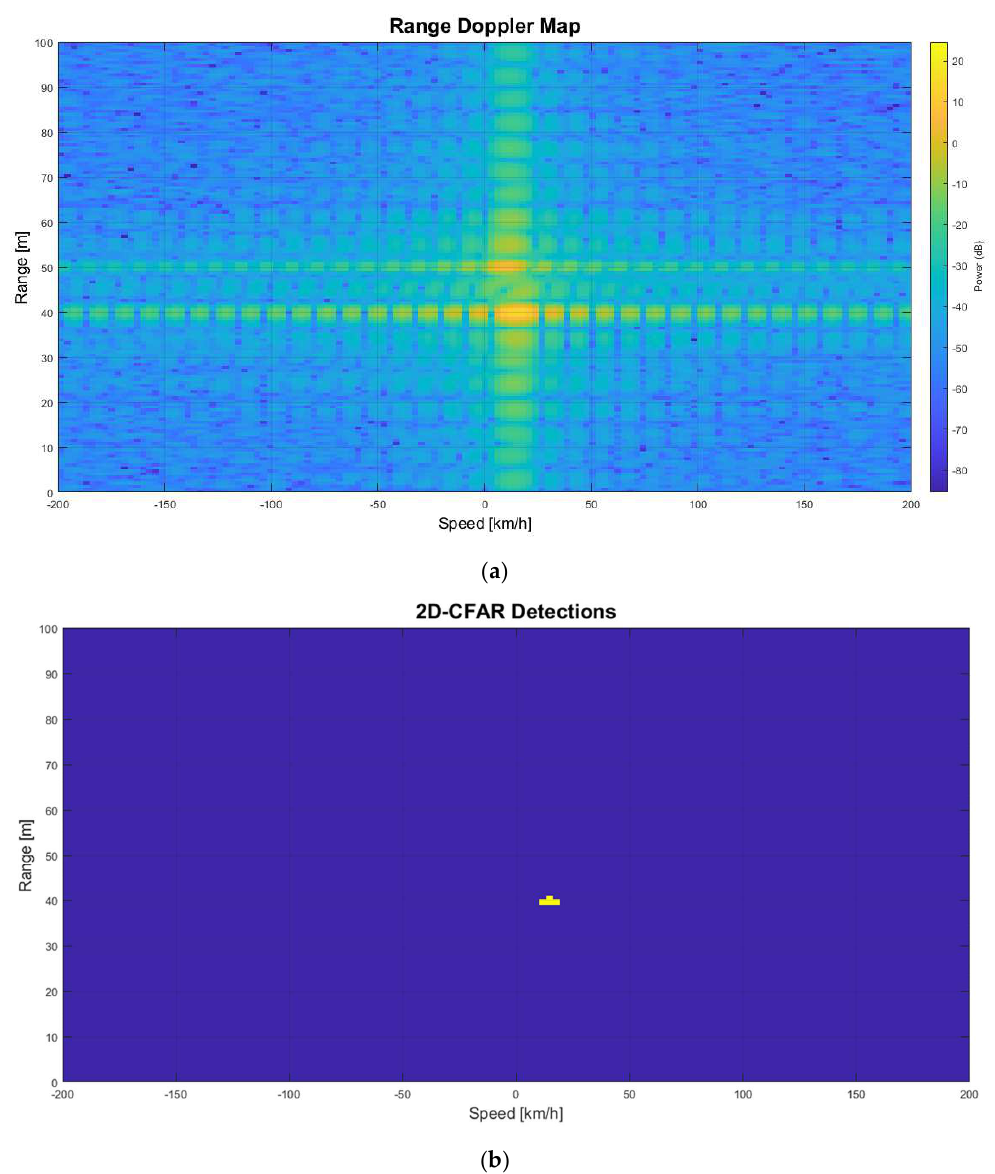
Figure 11. Jamming with JSR = 10. ( a ) Range-Doppler Map; ( b ) 2D-CFAR